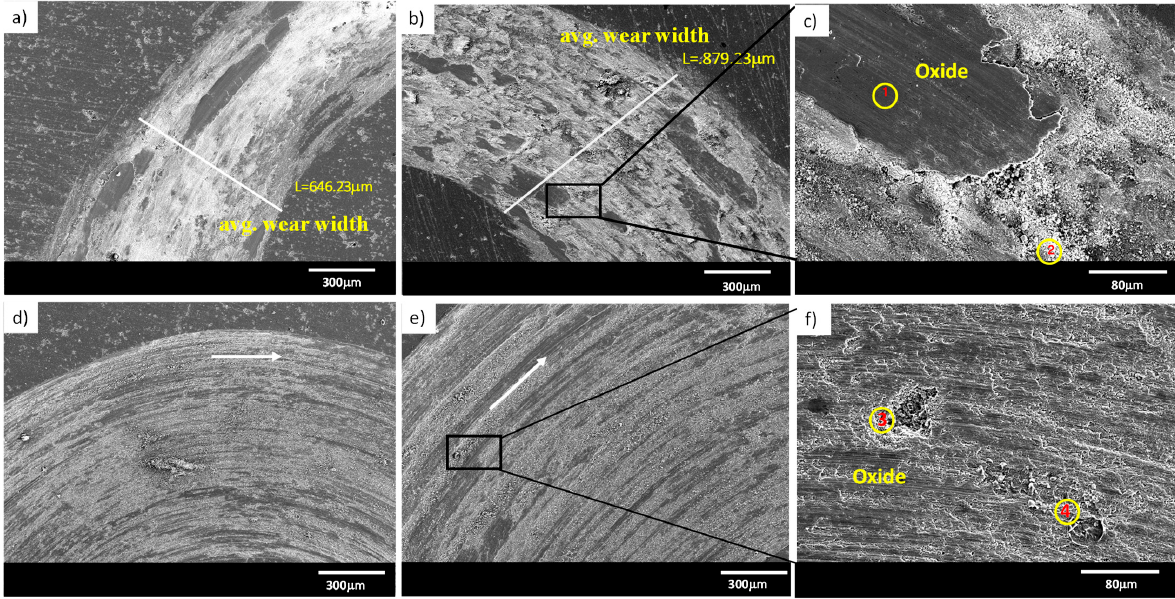
Figure 8. Worn scars of MMC Al-2024/TiC at 5 and 10 N EDX analysis with ( a – c ) 52100 steel and ( d – f ) ceramic ball counterparts. ( d – f ) ceramic ball Table 3. SEM-EDS compositional analysis of the yellow marks of Figures 8c and 8f.